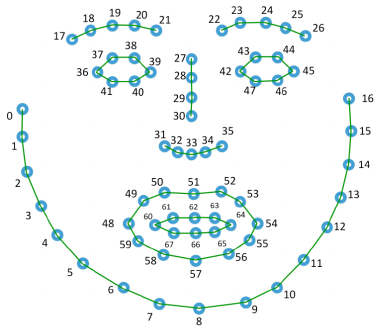
Figure 9. Base graph used with MSG3D.